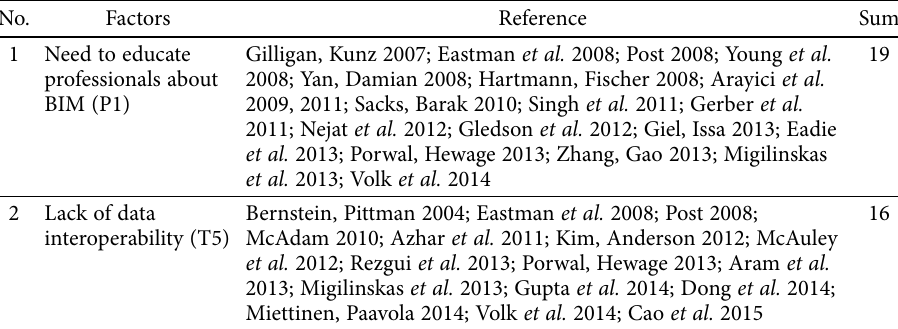
Table 2. Summary of limitation